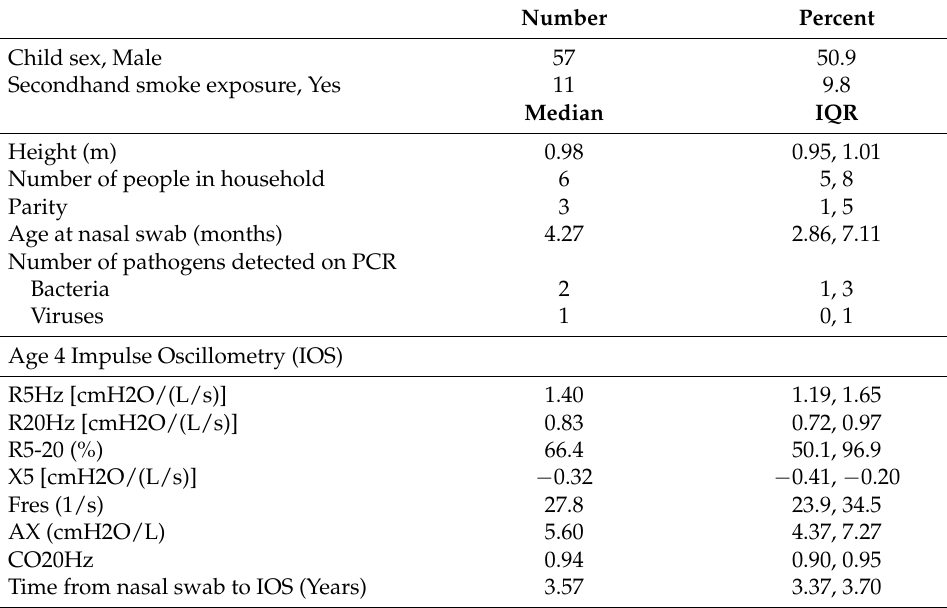
Table 1. Participant characteristics ( n = 112).